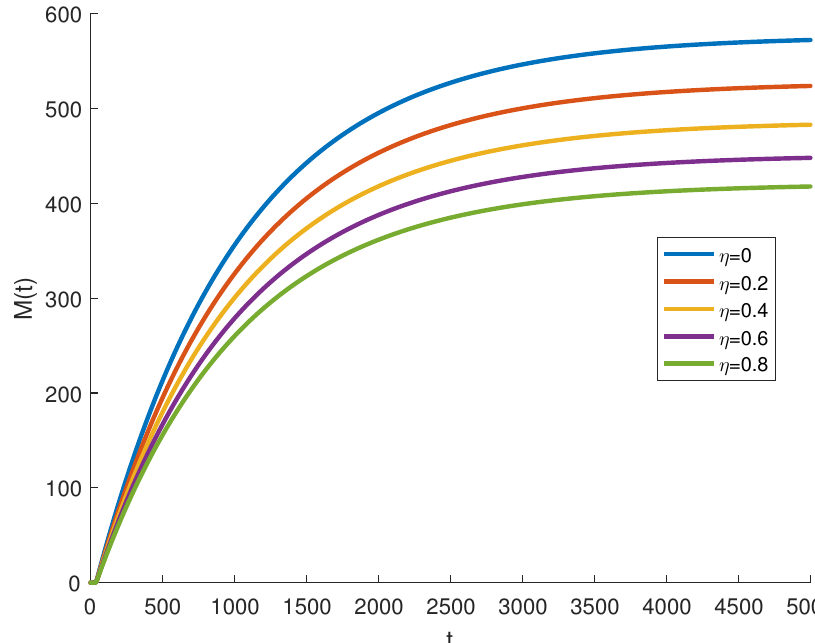
Figure 3. The RPW system (1) with different values of η